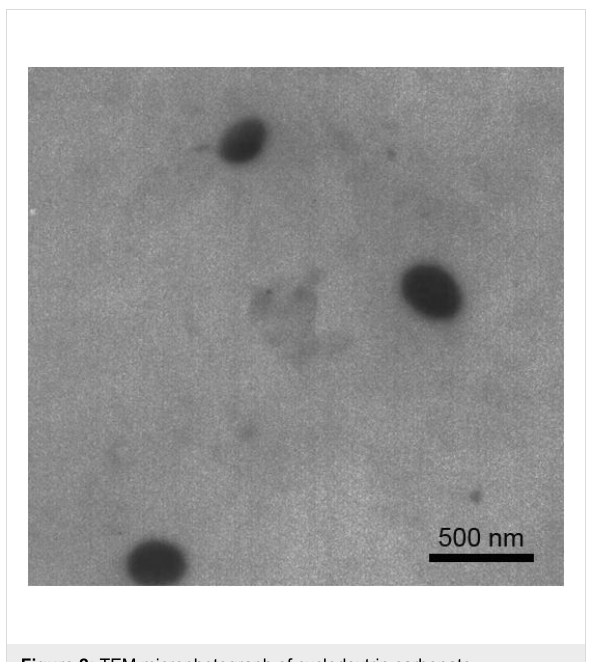
Figure 2: TEM microphotograph of cyclodextrin carbonate nanosponge (magnification